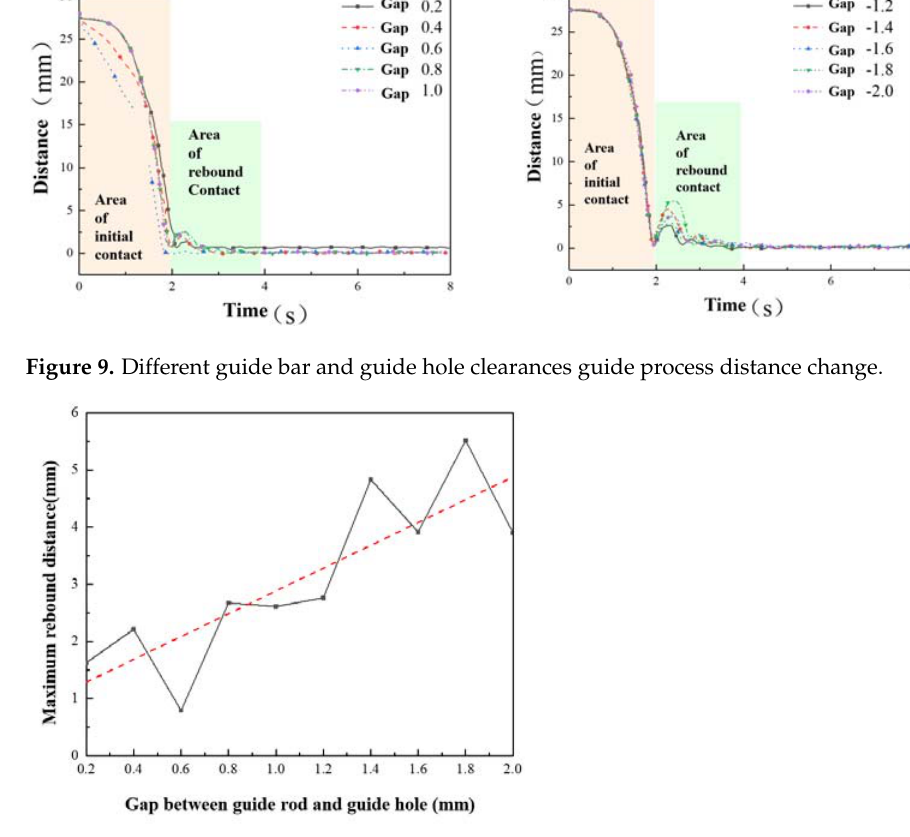
Figure 10. Maximum rebound distance of rebound guide area with different clearances.